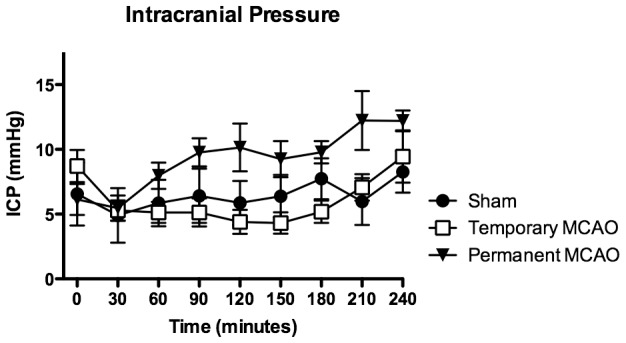
ICP after surgical MCAO, first 4 hours.ICP falls initially in all three groups due to dural opening and CSF aspiration. After skull reconstruction, ICP slowly rises above pre-craniotomy levels after permanent MCAO, but without any significant difference between groups.